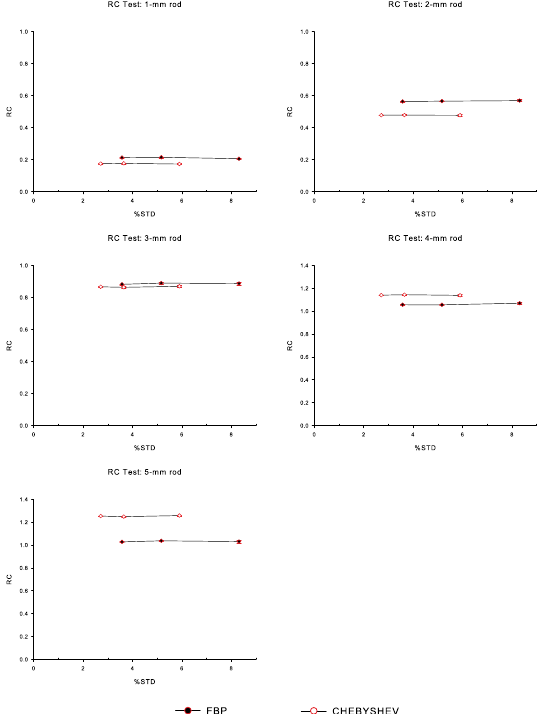
Figure 4. Recovery coefficient ( RC ) measurements for each of the hot fillable rods (diameters 1 to 5 mm) of the simulated IQ phantom, over the percentage standard deviation (% STD ), for Chebyshev and FBP reconstructions, corresponding to all noise levels. Note that the leftmost data point in each curve corresponds to NL1 (less noise), whereas the rightmost data point corresponds to the NL3